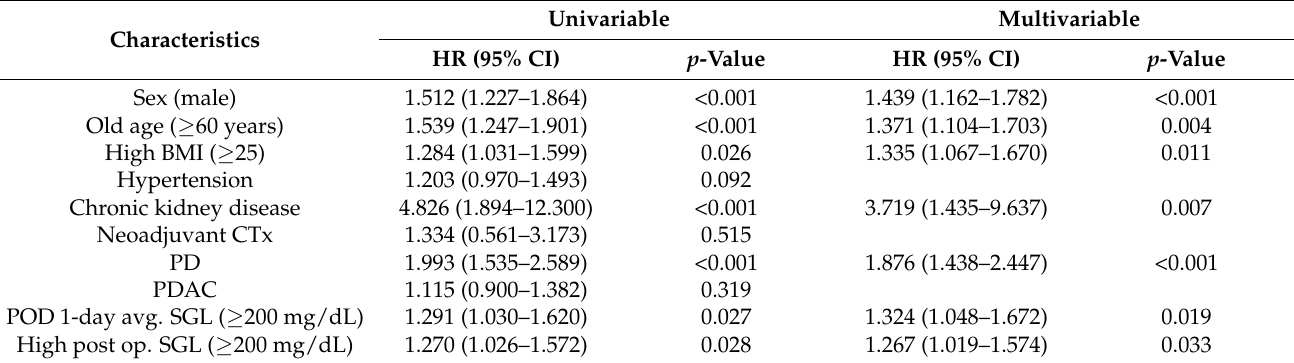
Table 3. Logistic regression for risk factor analysis of major complications.